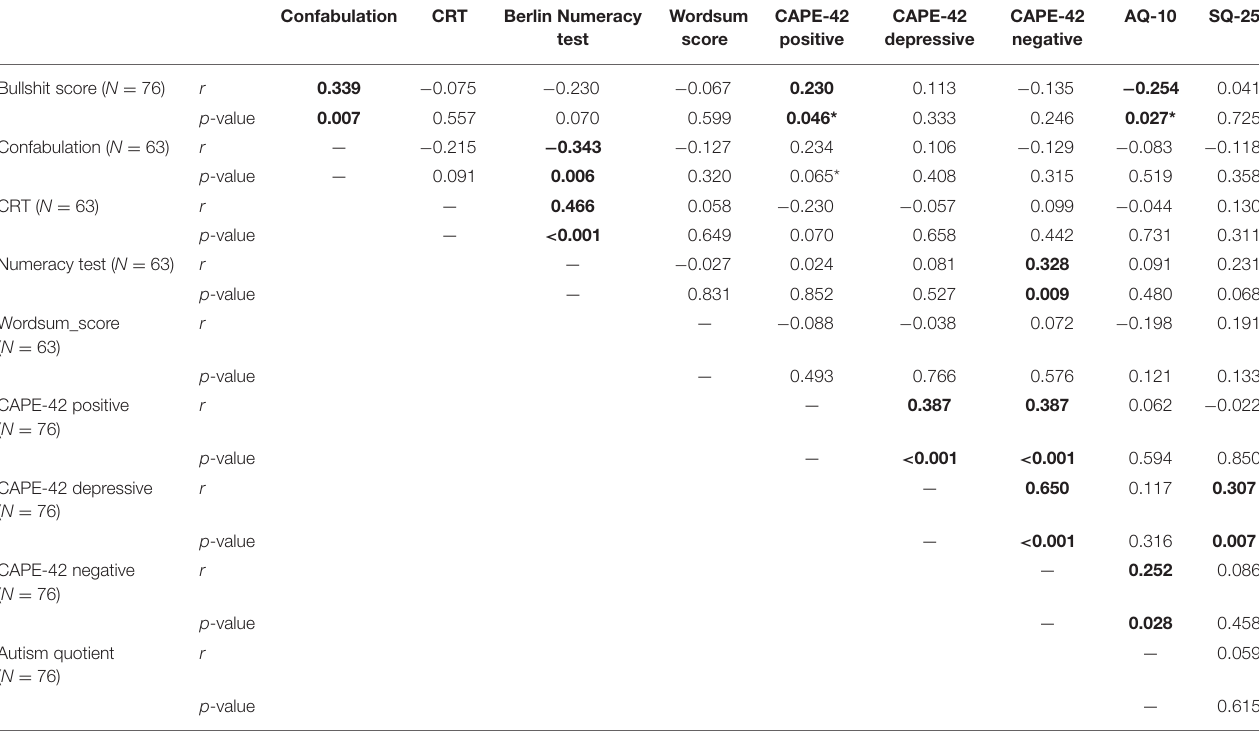
TABLE 4 | Pearson correlation between the five tasks and the five questionnaire